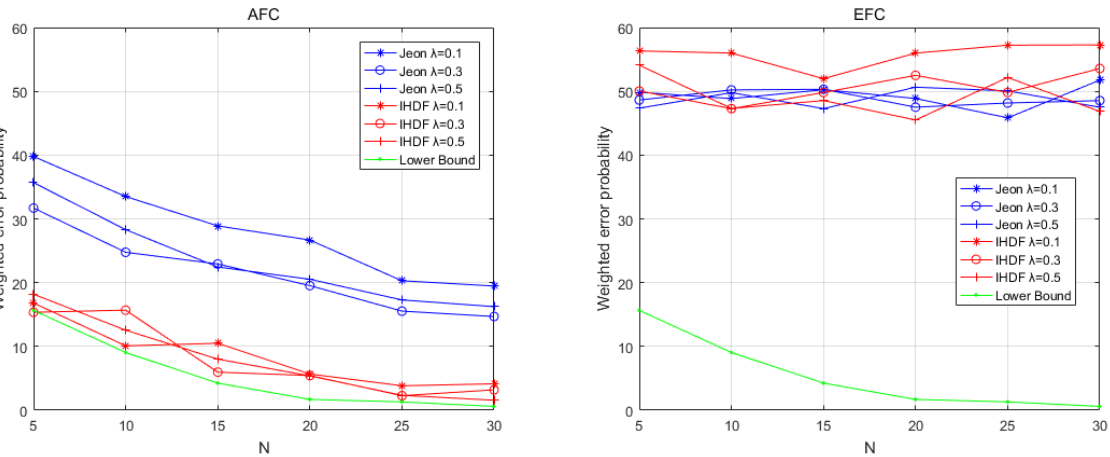
Figure 4. The weighted error probabilities at the AFC and EFC with an increasing number of sensors in ideal channel conditions.